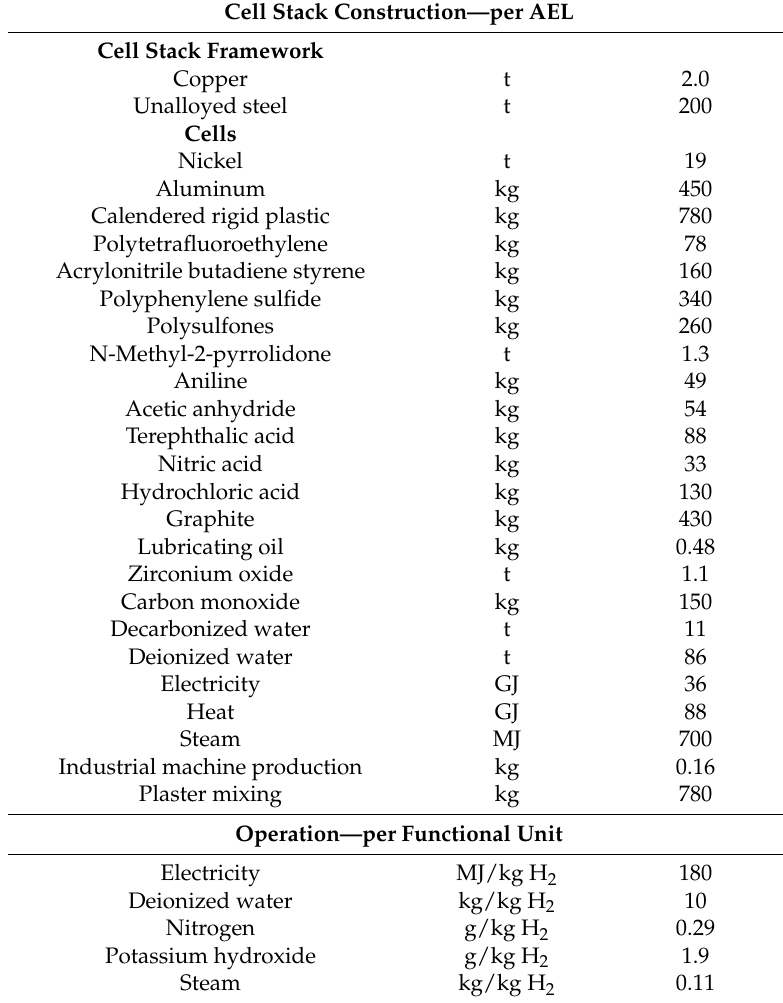
Table 3. Main material and energy